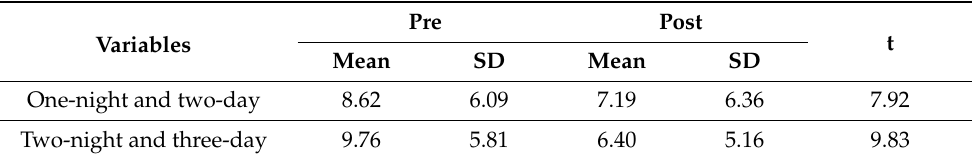
Figure 6. Comparison of the effects between the one-night and two-day and two-night and three-day programs for RCMAS.